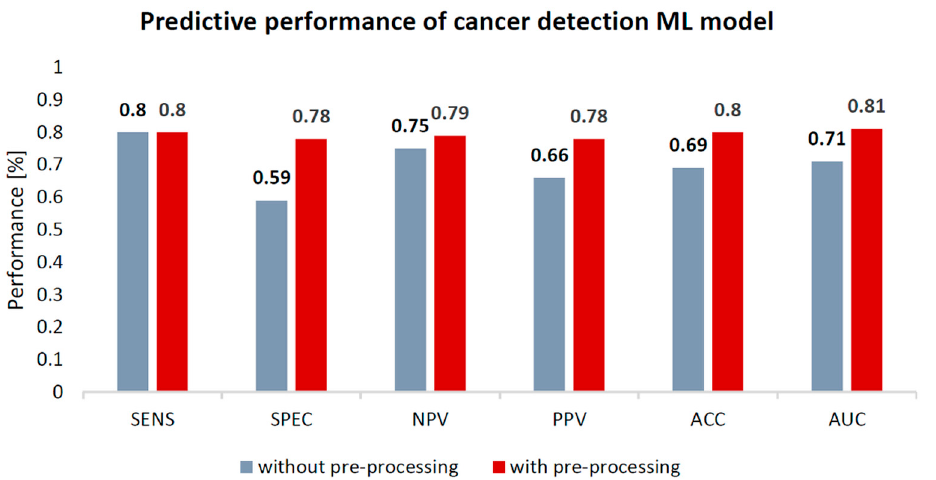
Figure 3. Performance comparison of breast cancer detection machine learning (ML) predictive models, with and without data pre-processing. ACC = Accuracy; SENS = Sensitivity; SPEC = Specificity; NPV = Negative Predictive Value; PPV = Positive Predictive Value. Performance is expressed in percentages (%).